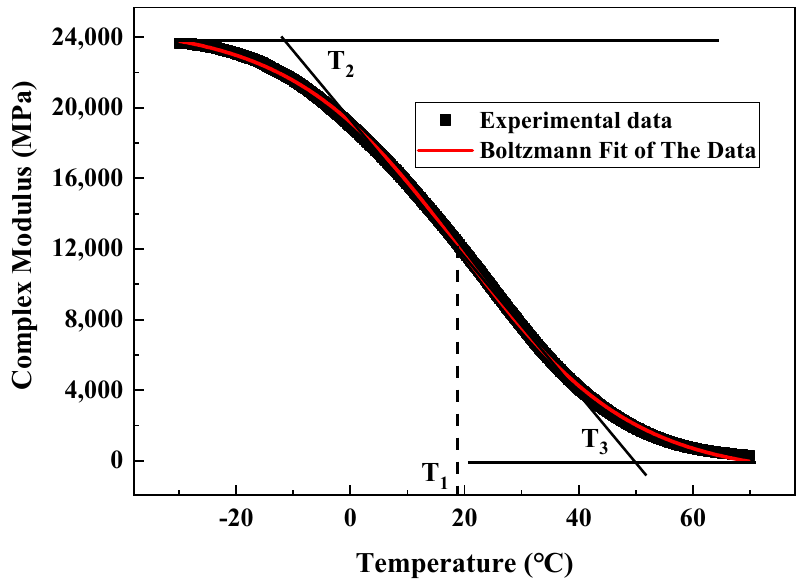
Figure 6. Schematic of complex modulus feature points.